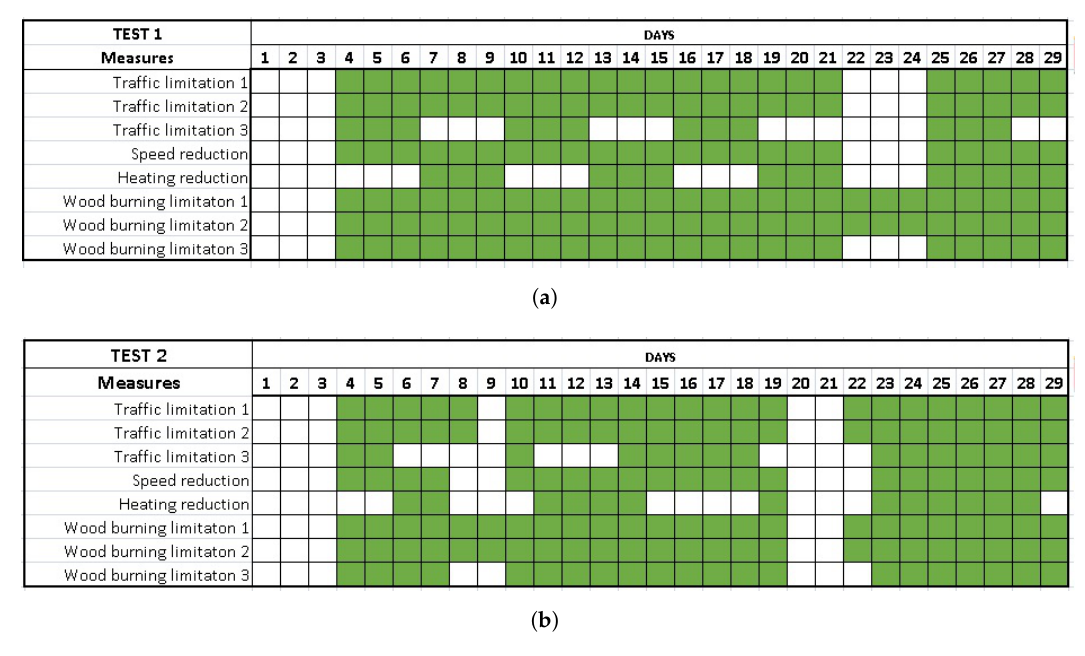
Figure 7. Resulting measure application for Test 1 ( a ) and Test 2 ( b ) for each day.